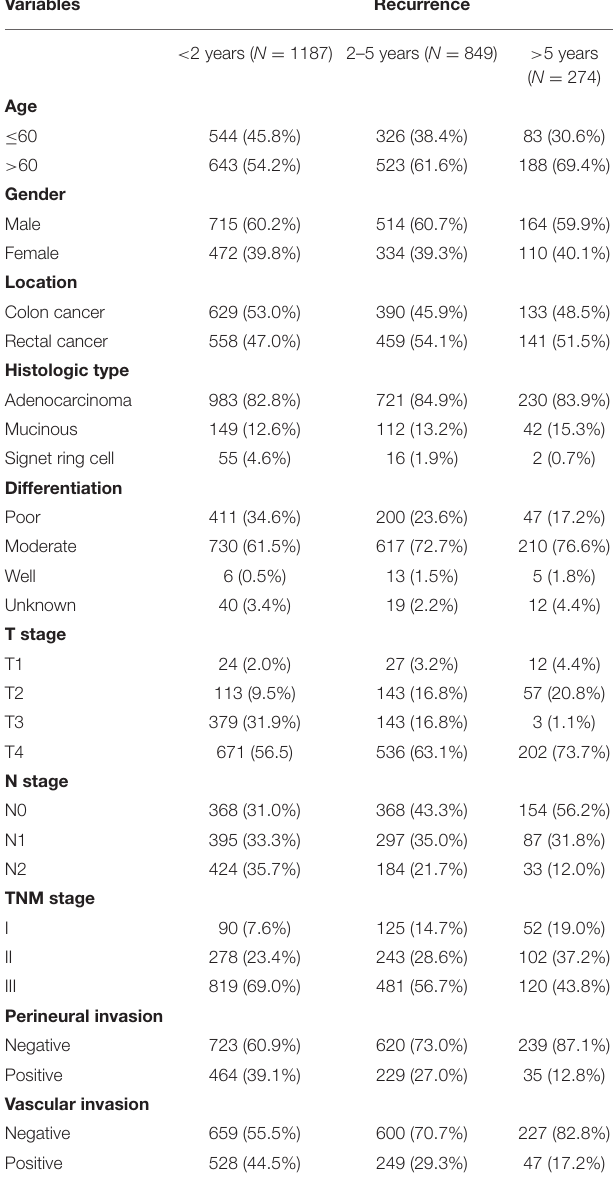
TABLE 1 | Clinicopathological features of stage I–III colorectal cancer (CRC) recurrence according to postoperative